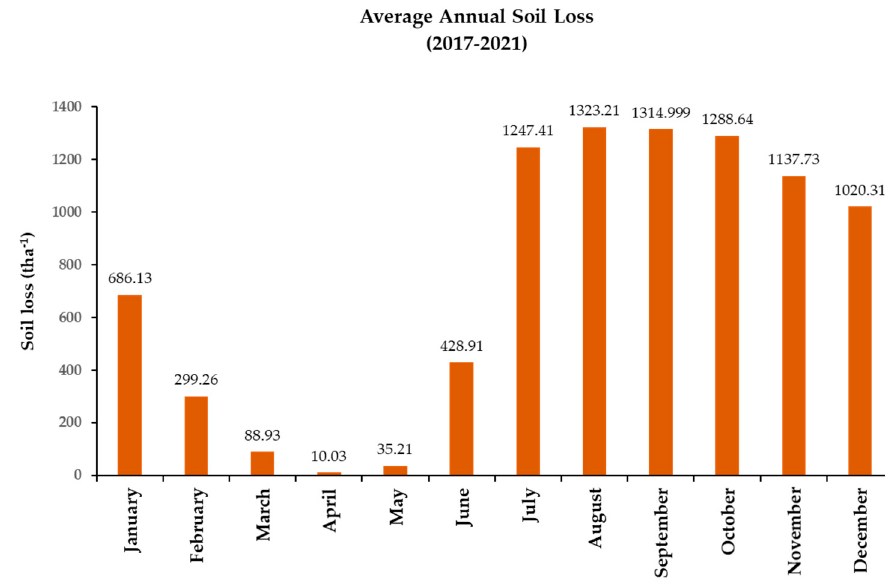
Figure 6. Average total monthly soil loss from 2017 to 2021.